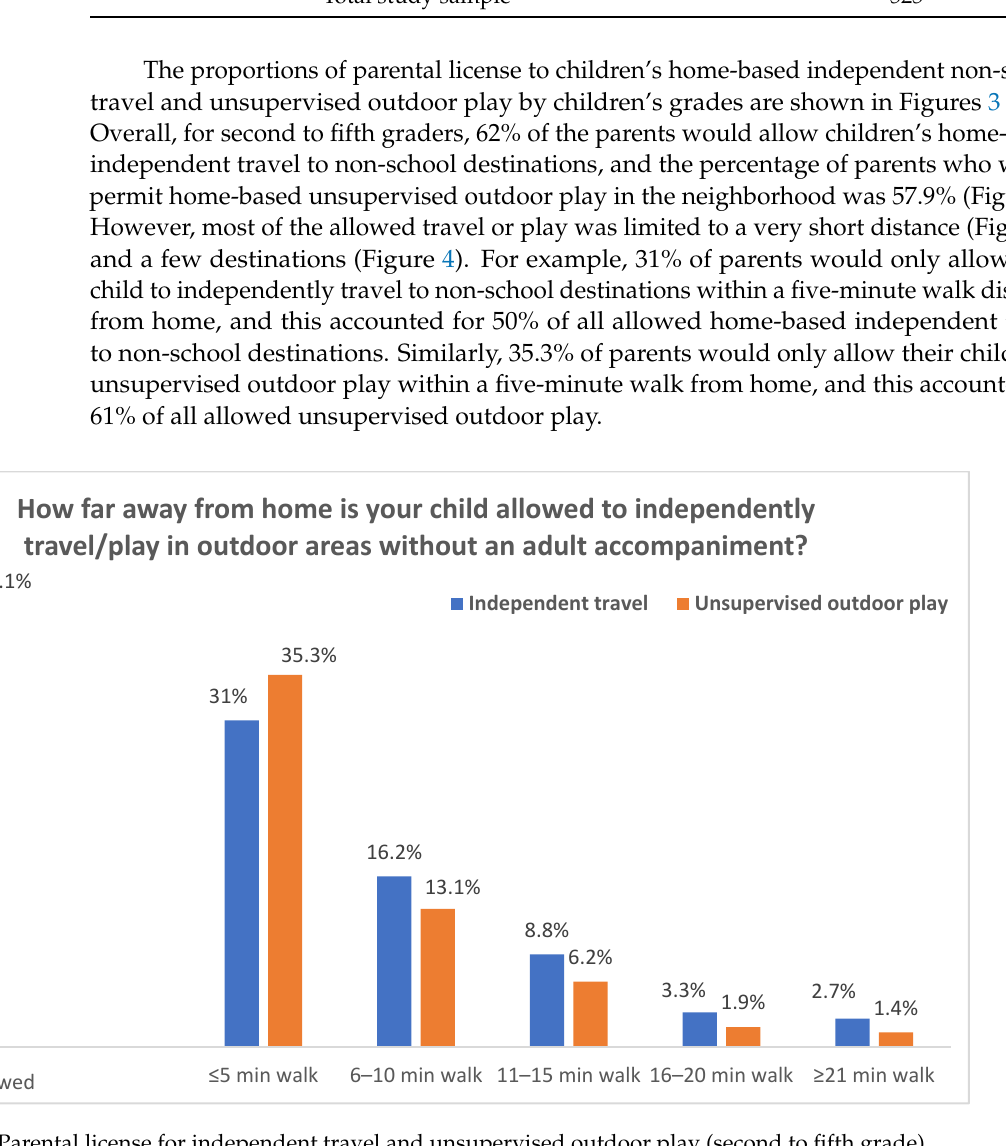
Figure 4. Non-school neighborhood destinations that children actually independently travel to ( n = 515). In order to better understand the spatial and temporal patterns of unsupervised play, the survey also asked about the availability of specific neighborhood amenities and places around homes, and how much time the child typically played there on a weekday or weekend day without adult supervision. Figure 5 illustrates the percentages of partici- pants having these neighborhood amenities, and among them, how much time their child spent for unsupervised play at each destination. Among participants who had these spe- cific amenities in their neighborhood, a friend’s or a relative’s home was where children